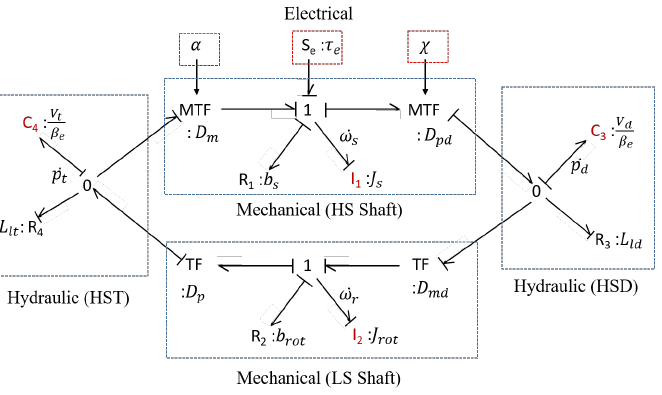
Figure 4. Energy conversion in the power-regenerative dynamometer. A high-fidelity mathematical model was developed to represent the dynamic behavior of the power-regenerative dynamometer [16]. The dynamometer is governed by high speed (HS) generator shaft dynamics, low-speed (LS) rotor shaft dynamics, and HSD and HST pressure dynamics. The dynamic equation consists of four states, HS shaft speed, ω s , rotor speed, ω r , HSD pressure, p d , and HST pressure, p t ; and three inputs, HSD pump normalized swash plate angle, χ , HST motor normalized swash plate angle, α , and the electric motor torque, τ e , as shown in Equations